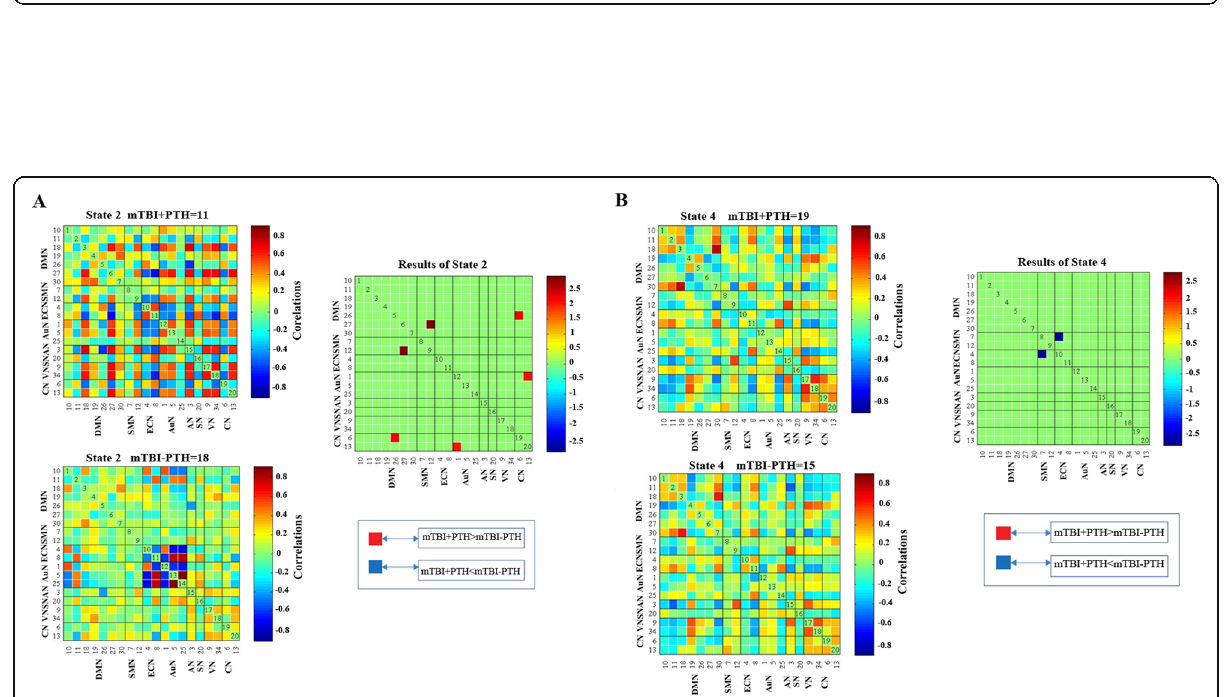
Fig. 3 Results of the clustering analysis per state. Cluster centroids for each state. The total number of occurrences and percentage of total occurrences are listed above each cluster median